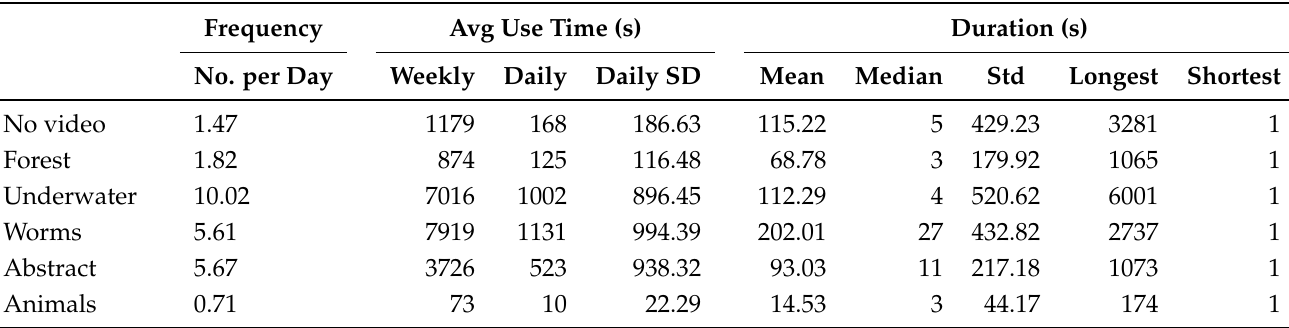
Table 5. Interaction details per monkey.